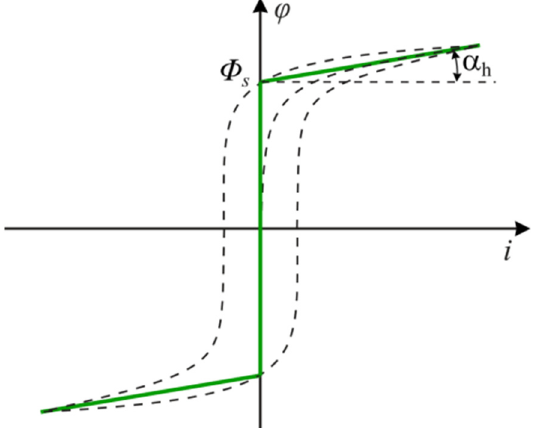
Figure 5. Simplified shape of the magnetisation curve.